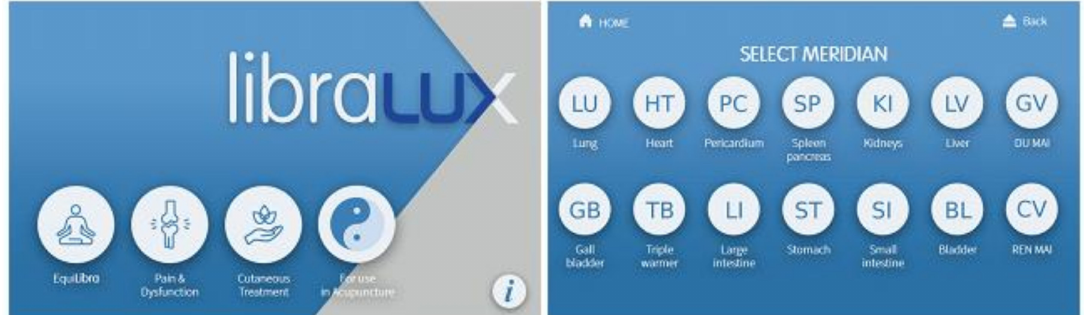
Figure 5. Libralux Acupuncture Mode. Note: (**) (**) Triple Energizer (TE) is still coded as TB (Triple Burner) and Liver LR is still coded as LV with a superseded coding—Software will be